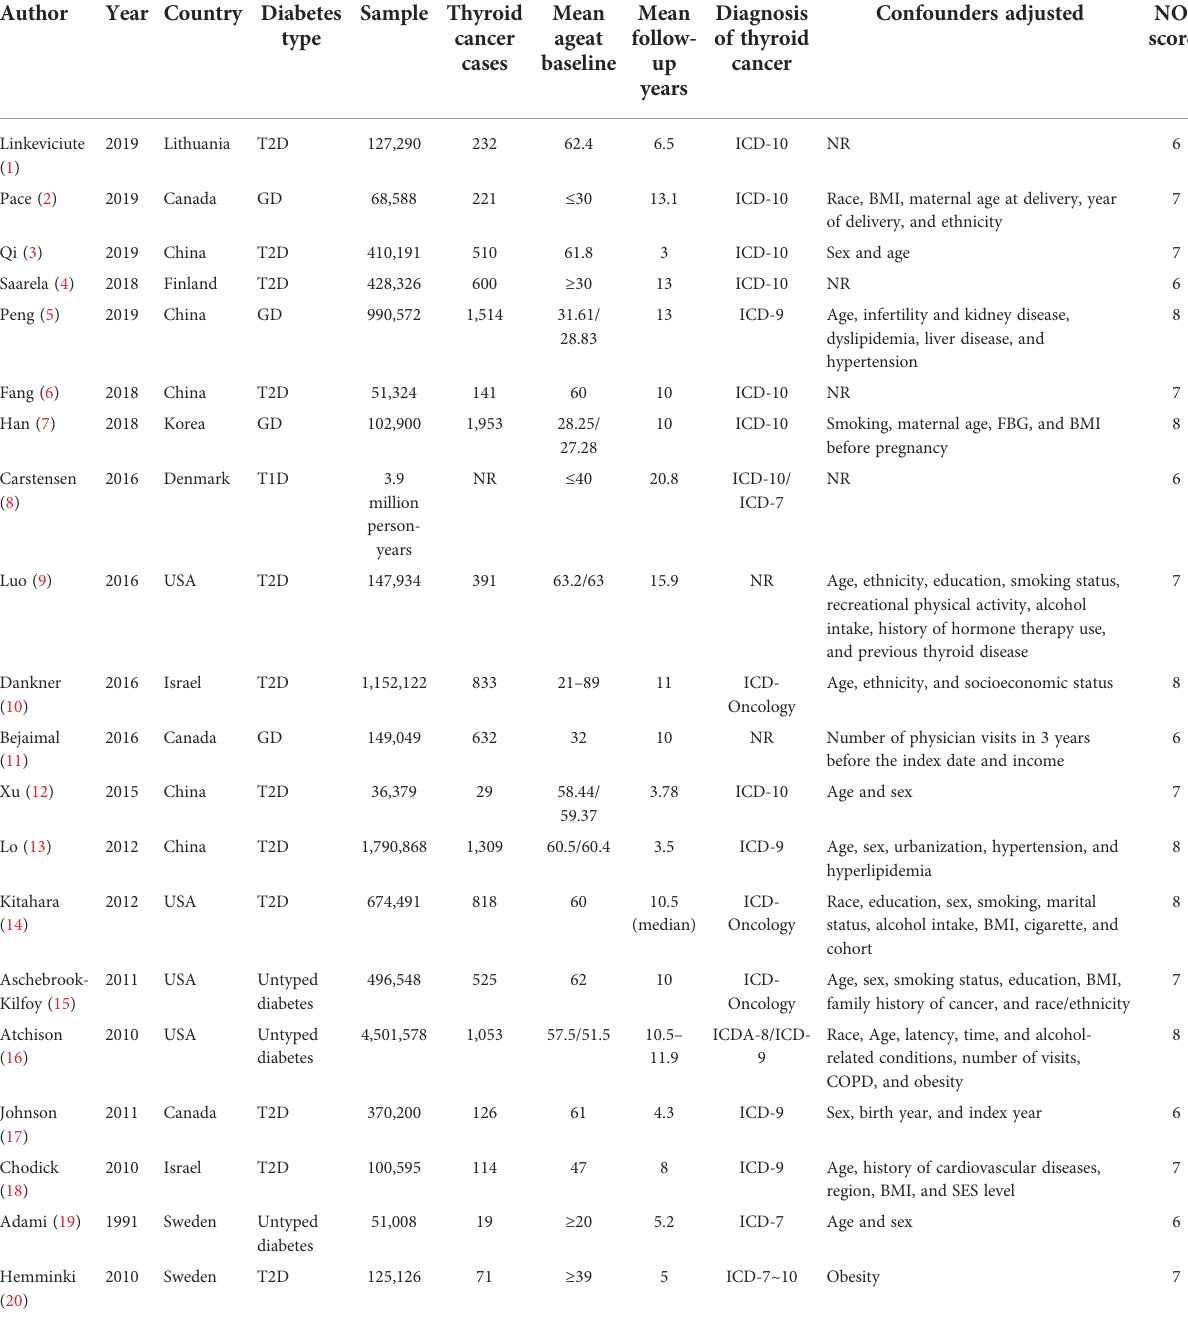
TABLE 1 Basic characteristics of the included